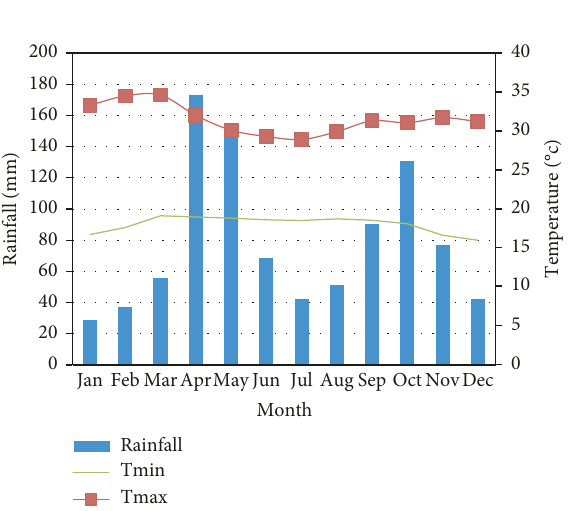
Figure 2: Average monthly rainfall and temperature (1987–2018) for Arba Minch district. Source: National Meteorological Agency